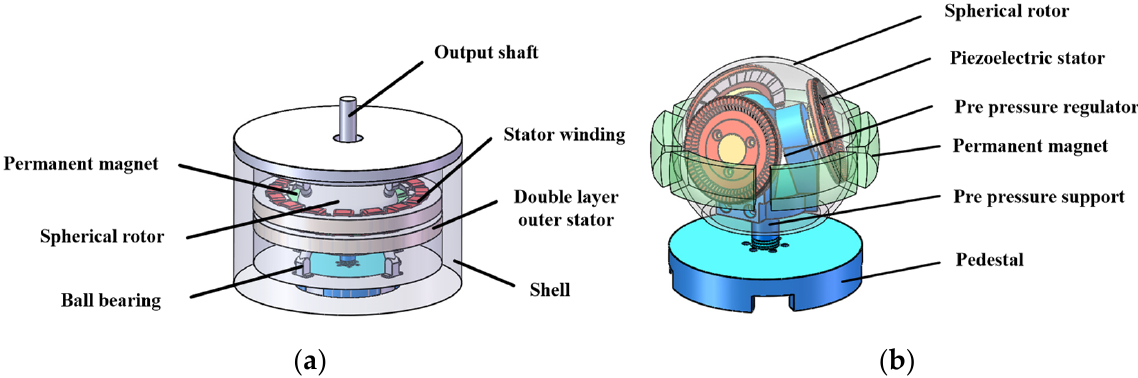
Figure 1. Structure of motor: ( a ) External electromagnetic drive; ( b ) Internal piezoelectric drive. The double-layer stator of the electromagnetic drive part surrounds the equator of the rotor. The permanent magnet table is posted on the outside of the spherical rotor, six permanent magnets surround the equator of the rotor, and three N poles and three S poles are alternately distributed [2]. The three piezoelectric stators of the piezoelectric driving part are uniformly distributed in the spherical rotor, and the piezoelectric ceramic sheet (PCS) is attached to the bottom of the piezoelectric stator after silver plating polarization. The pre-pressure regulating device is shown in Figure 2, adjust the preload through the preload adjusting hole at the bottom of the base to make the preloading rod rise. At the same time, deduce the stator slider to make the stator rise and contact the rotor [19]. There are friction materials on the inner of the rotor, which can increase the driving force of the rotor and reduce the friction loss of the stator and rotor [3]. Ball bearings are used to support the rotor to decrease the gravity of the rotor itself and reduce the loss of the motor [20].